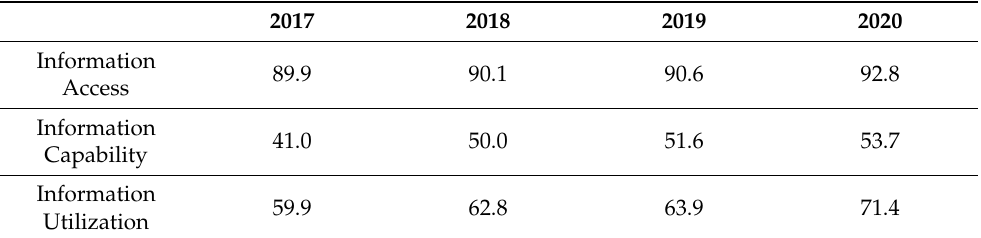
Table 4. Digital Informatization Level of Older People by